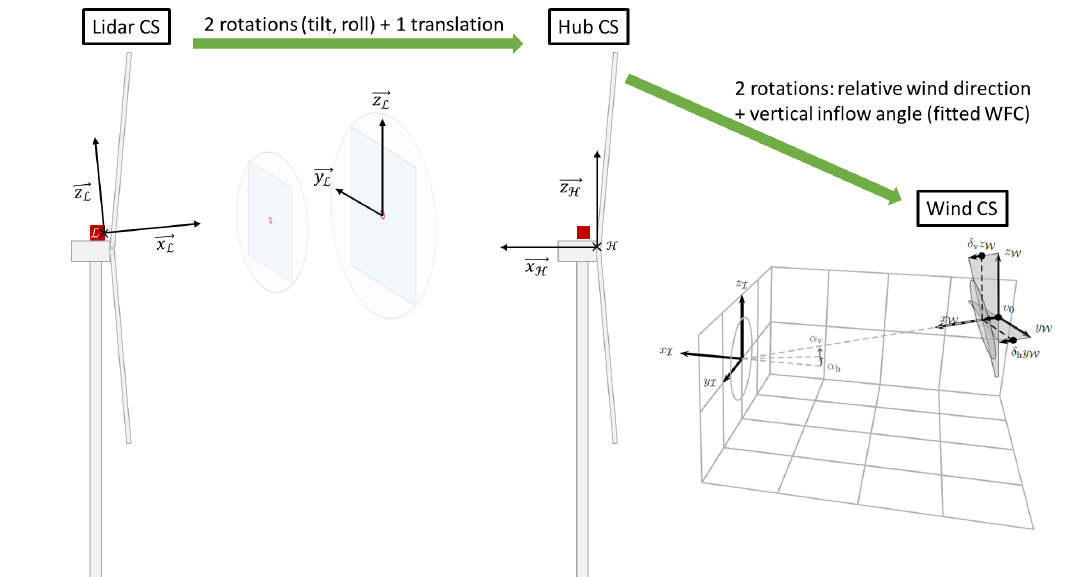
Figure 2. Schematic and relation between used lidar, hub and wind coordinate systems.